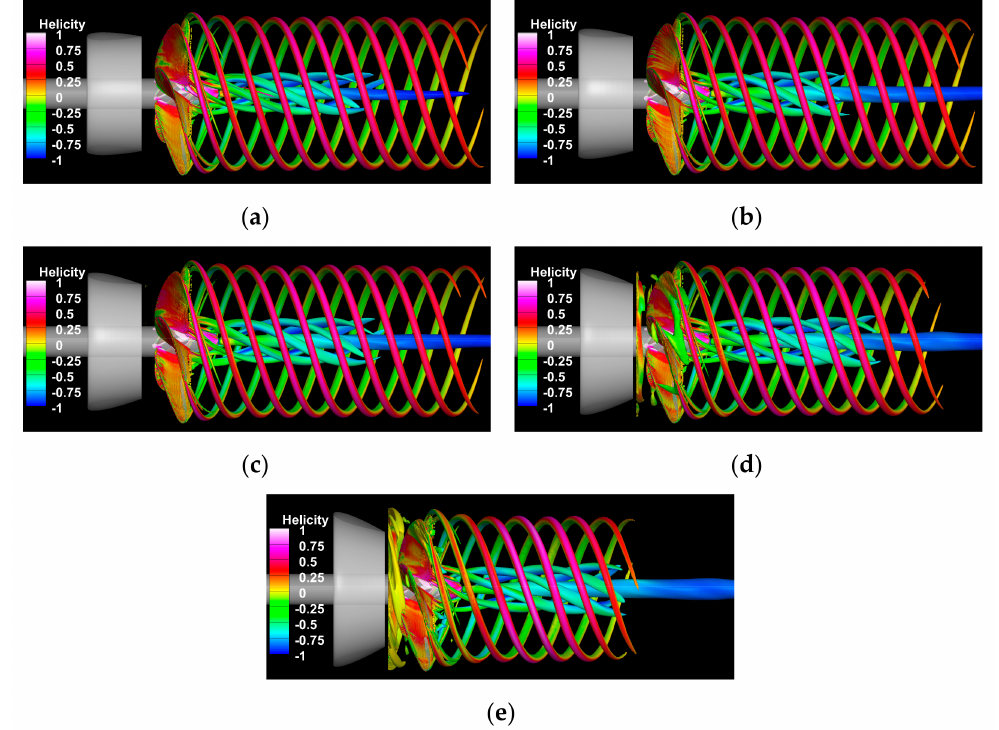
Figure 19. Vortices released by the nozzle-propeller ensemble working in open water, computed as iso-surfaces of Q = 15,000. ( a ) θ = 0 ◦ , ( b ) θ = 5 ◦ , ( c ) θ = 10 ◦ , ( d ) θ = 15 ◦ , ( e ) θ = 20 ◦